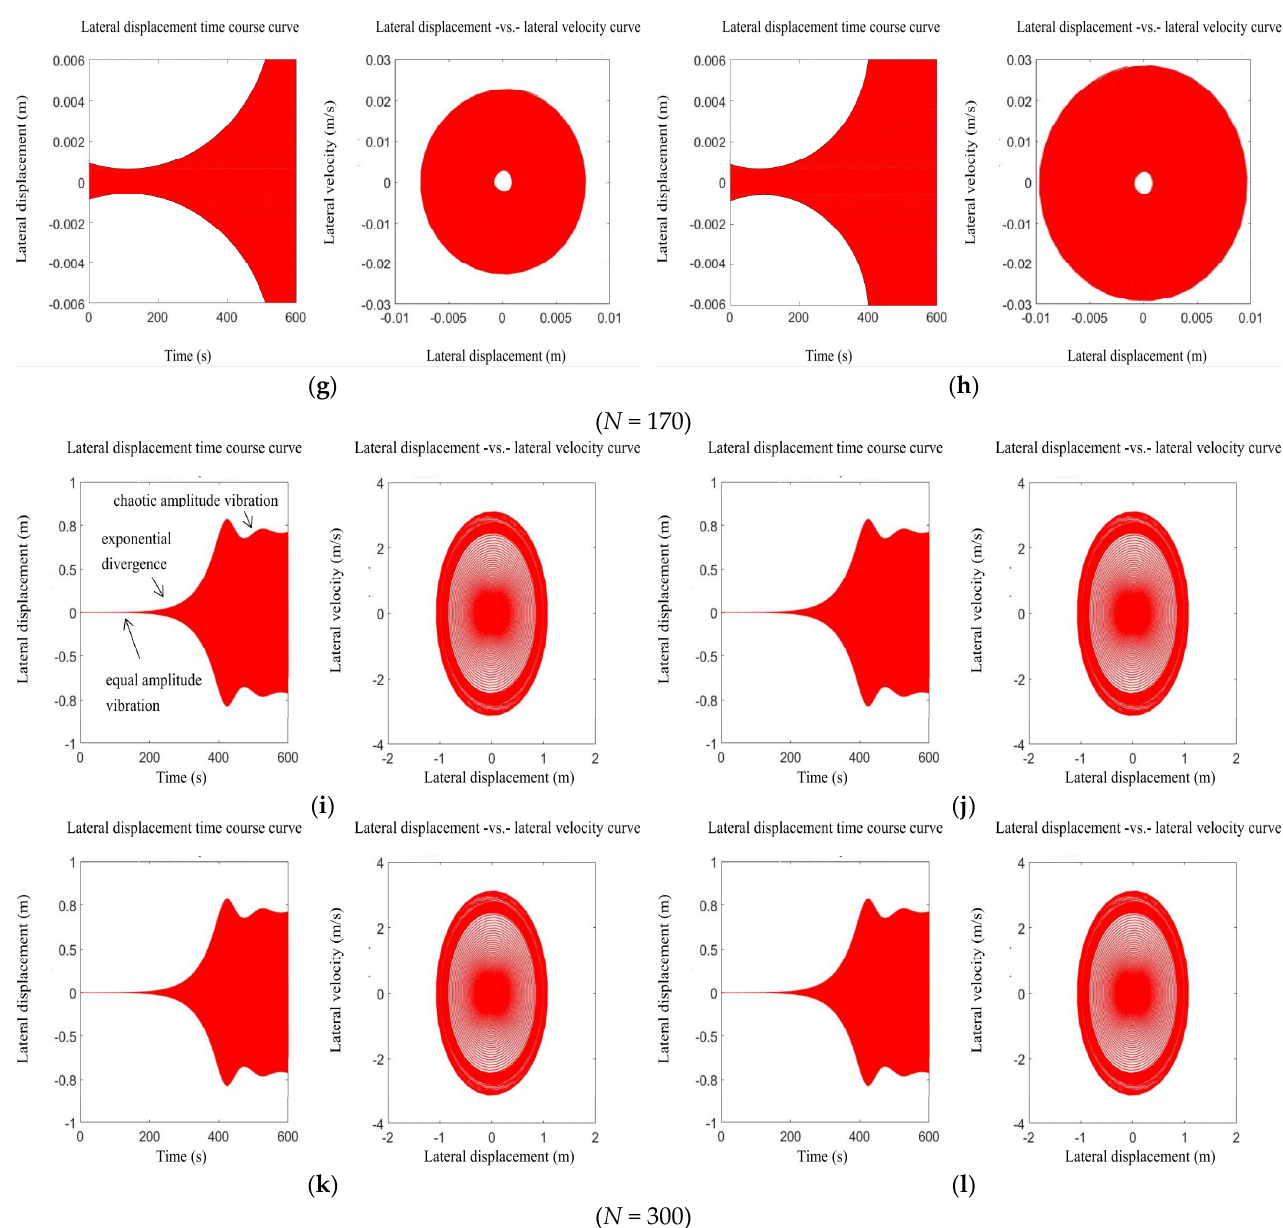
Figure 4. Displacement time-course curve and phase plane curve ( N = 50, 170, 300). ( a ) τ = 0 s. ( b ) τ = 0.2 s. ( c ) τ = 0.4 s. ( d ) τ = 0.6 s. ( e ) τ = 0 s. ( f ) τ = 0.2 s. ( g ) τ = 0.4 s. ( h ) τ = 0.6 s. ( i ) τ = 0 s. ( j ) τ = 0.2 s. ( k ) τ = 0.4 s. ( l ) τ = 0.6 s.